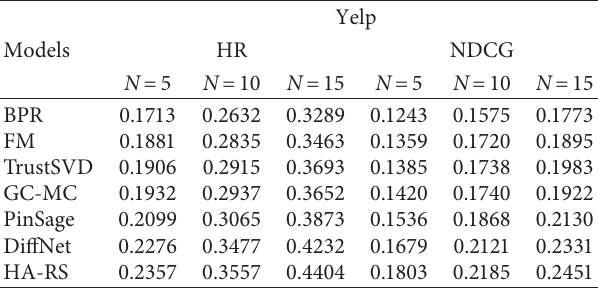
Table 4: HR@N and NDCG@N comparisons for different top- N